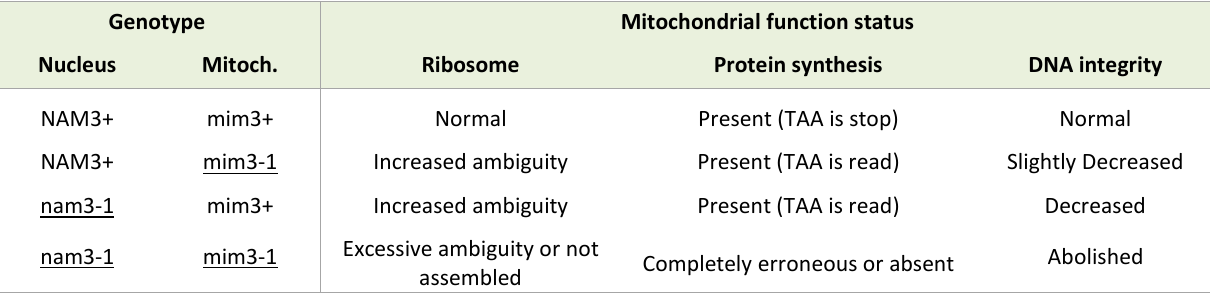
TABLE 4. Summary of interaction between mim3-1 and nam3-1 ochre suppressors and their effects on